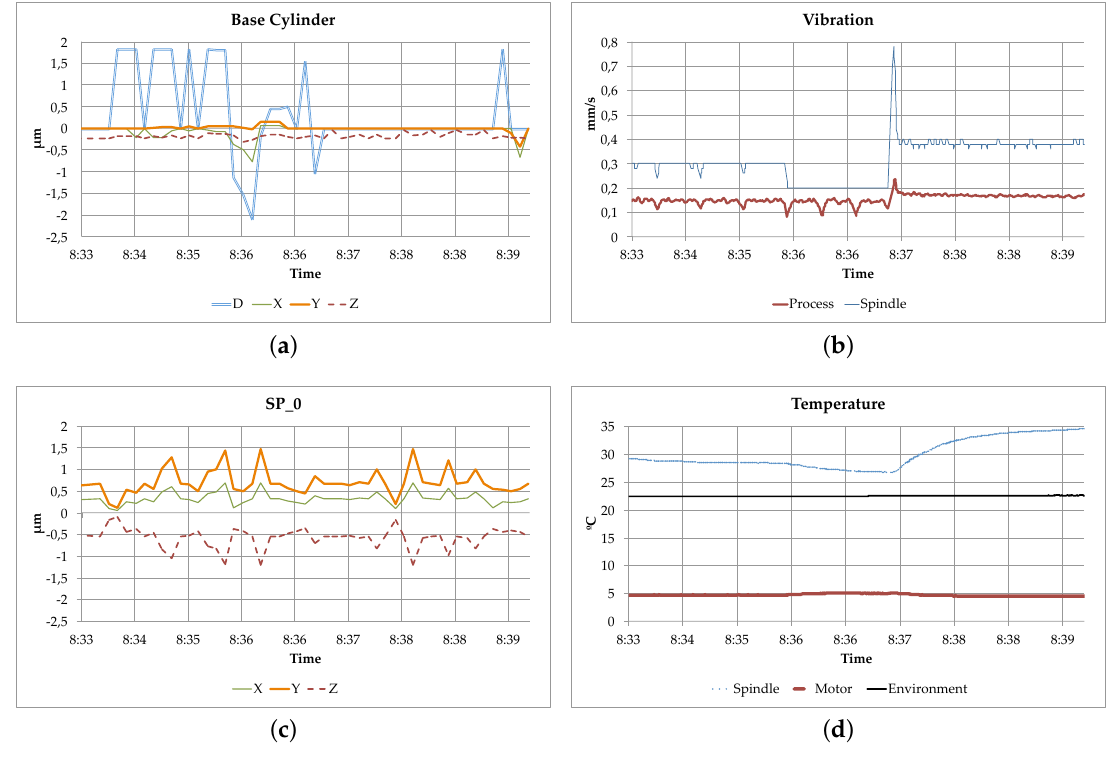
Figure 8. Quality Control Display. ( a ) Coordinate Measuring Machine Base Cylinder; ( b ) Milling Machine Vibration; ( c ) Coordinate Measuring Machine SP_0; ( d ) Milling Machine